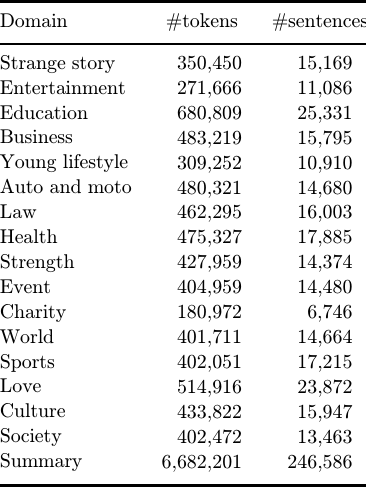
Table 4. The statistic of Dantri